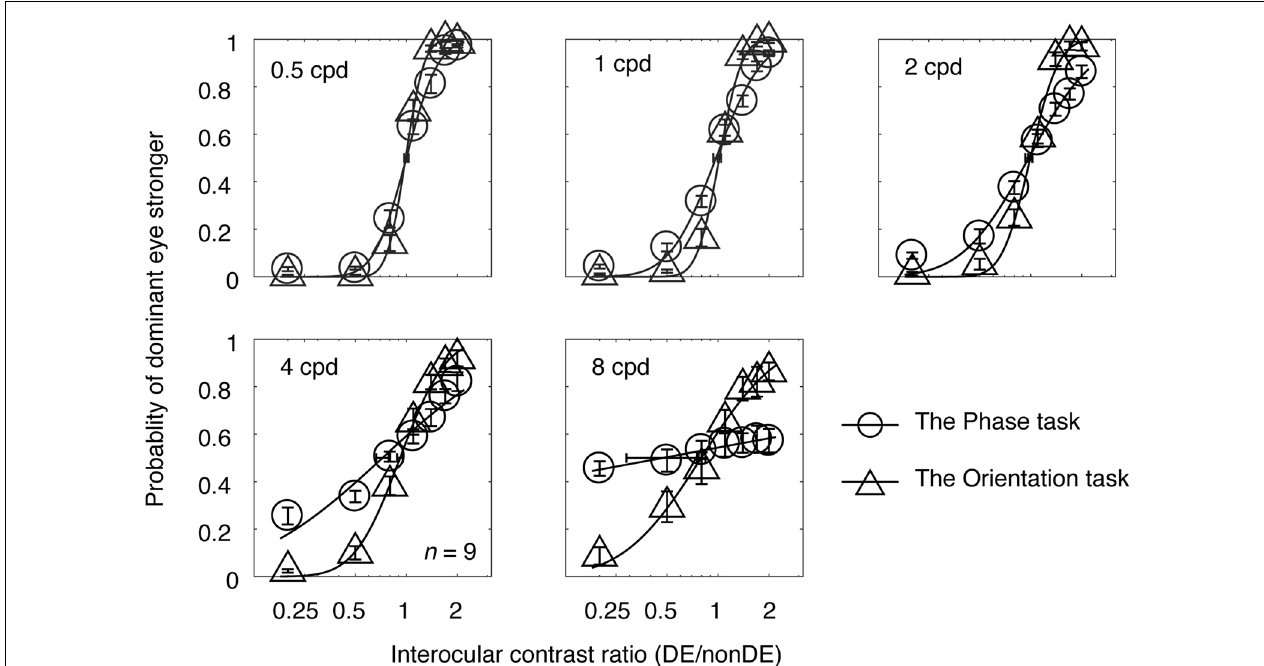
FIGURE 2 | The average psychometric functions for the two tasks. Data of different spatial frequencies are shown in separate panels. In each panel, the mean probability of the dominant eye stronger was plotted as a function of interocular contrast ratio (DE/non-DE) for the two tasks. The solid and dash line represents the best fitting cumulative distribution functions for the two tasks. Error bars represent SEs across the nine subjects. The horizontal error bars in each graph indicate the derived PSE (the PSE, i.e., the point at which the two eyes were balanced in binocular combination) and its bootstrapped SEs (based on 100 times’ parametric bootstrapping